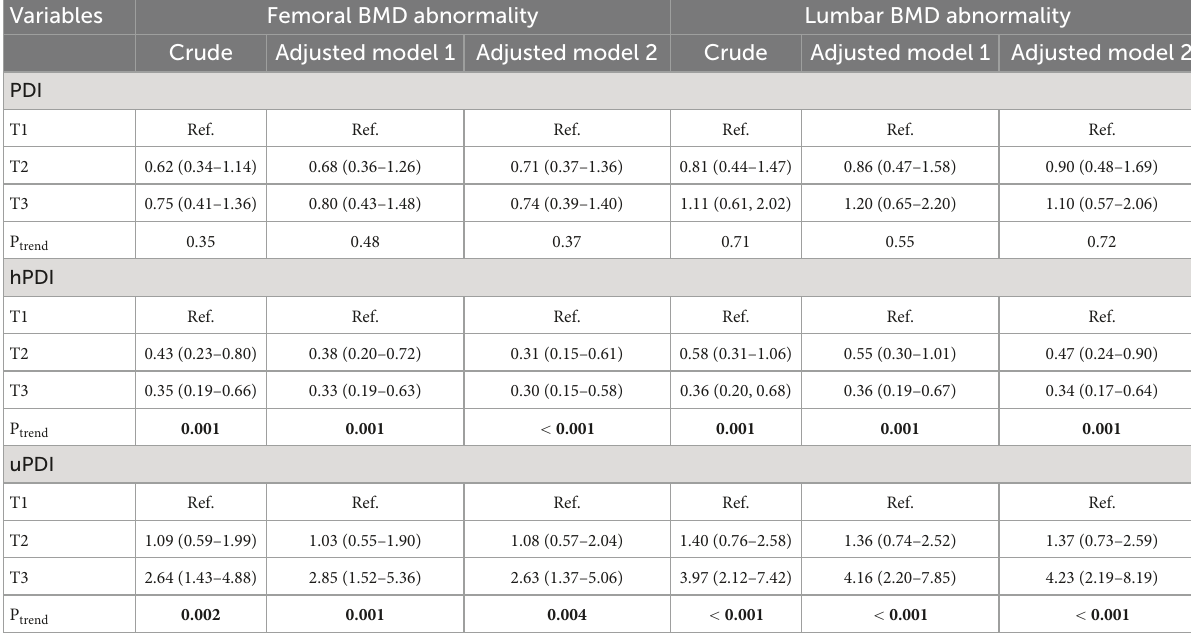
TABLE 4 Crude and multivariable-adjusted odds ratios and 95% CIs across tertile of plant-based diet index (PDI), healthy plant-based diet index (hPDI), and unhealthy plant-based diet index (uPDI).